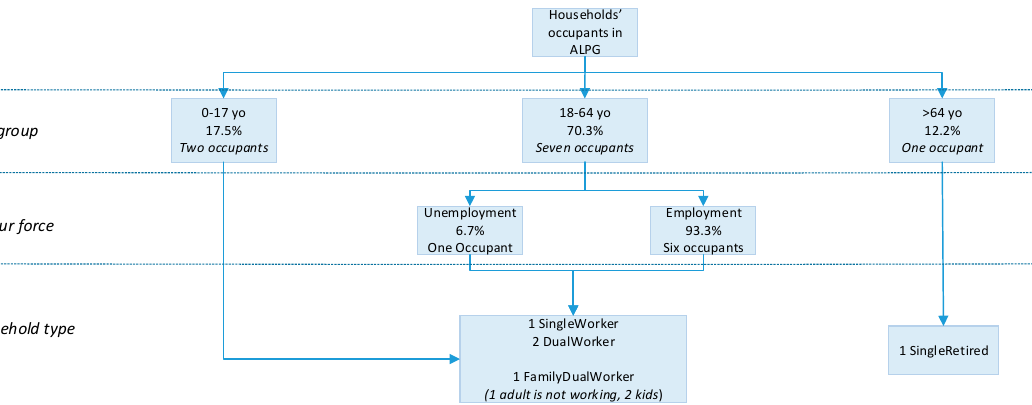
Figure 7. The snipped code of the configuration of the selected household profiles in ALPG based on Wepro model.